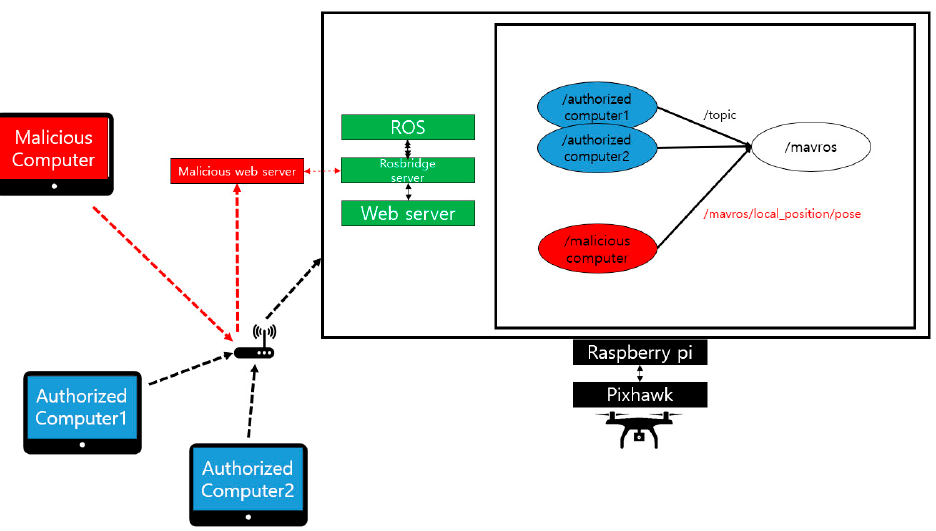
Figure 17. Attack in nonnative ROS.